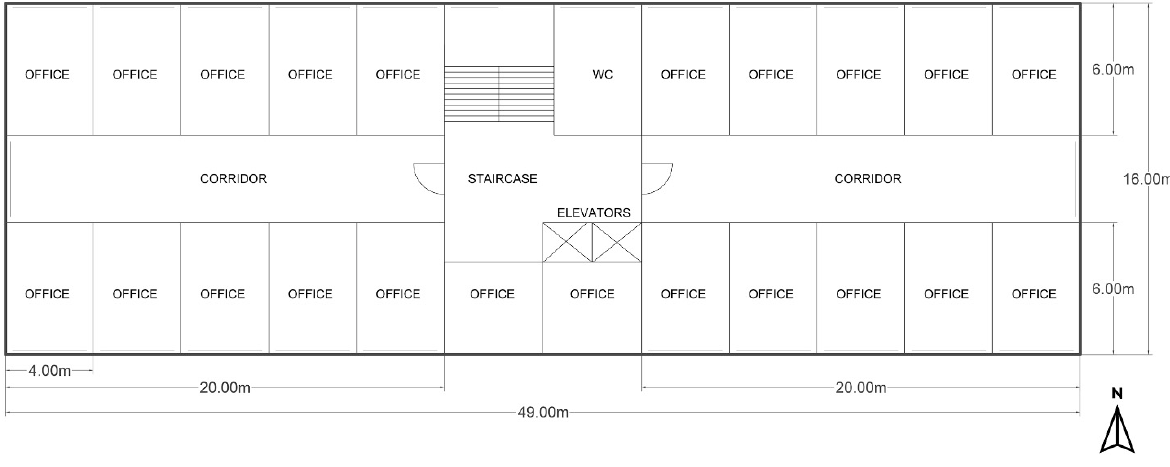
Figure 8. Plan view of the building’s typical floor.